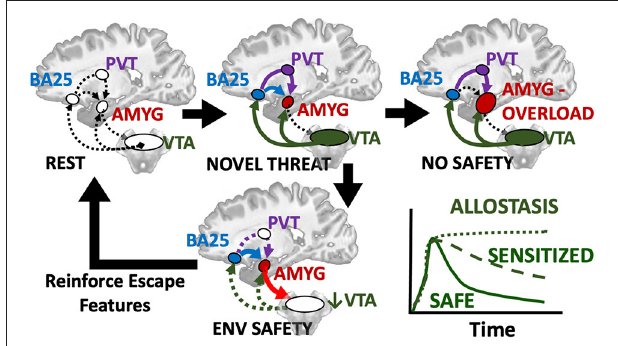
FIGURE 5 | Hypothesized loop by which a novel threat activates alerting/approach related ventral tegmental area (VTA) which provides dopaminergic innervation to prefrontal regions including the subgenual BA25 sends the resultant evaluation of situational safety through the uncinate fasciculus (blue) to basal and lateral amygdala nuclei and simultaneous threat signals through the paraventricular thalamus (PVT, purple) to the centromedial amygdala effectors. Co-activation of BA25 and amygdala safety circuits deactivates the VTA and cues encoding safety or escape are retained and reinforced as reward. If no safety is achievable, chronic activation of BA25 and amygdala including dopamine signals from the VTA lead to fear generalization or sensitization and favor the PVT relay and latent fears. A transient response or deactivation of dopamine appears to be a key manifestation of